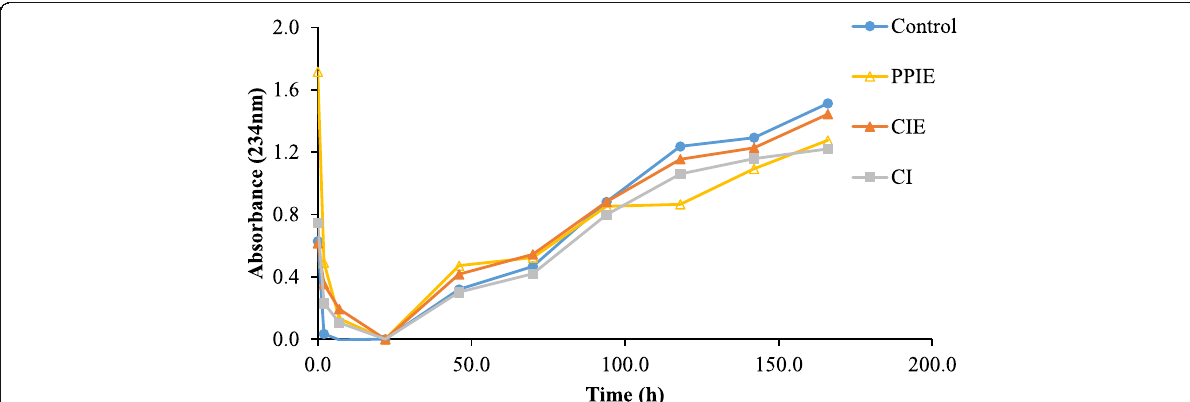
Fig. 7 Conjugated dienes formation from lipid oxidation in emulsion gels influenced by adding inulin. Emulsion gel containing PPIE (primary purified inulin extract from JA); CI (commercial inulin from chicory root); CIE (crude inulin extract from JA) and control (without inulin). Data points represent means ( n = 3). One-way ANCOVA followed by post-hoc Tukey ’ s test is used to find significant differences ( α = 0.05). Results are different when P <